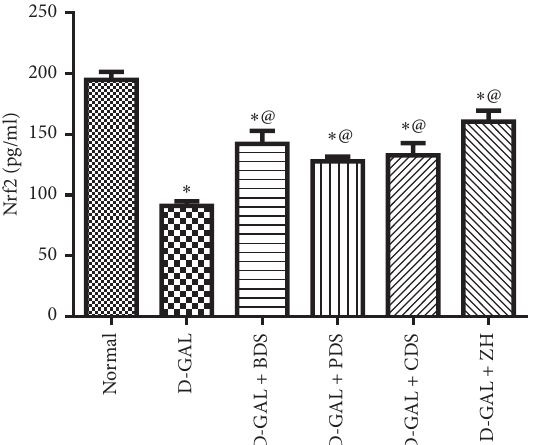
Figure 2: Effect of D. salina on hepatic Nrf2 levels in albino rats with age-related hepatic steatosis. Age-related hepatic steatosis was induced in rats by injections of D-galactose (300 mg/kg I.P) 5 days/week for 6 weeks. Rats injected with oral D-galactose for two weeks were treated with BDS (450mg/kg), PDS (30mg/kg), CDS (30mg/kg), or ZH (250 μ g/kg). Twenty-four hours later, the last dose of the treatment, rats were sacrificed and liver tissues were homogenized. Tissue homogenate were used for Nrf2 measurement. Data are expressed as mean ± SEM from the normal value. Statistical analysis was performed by one-way analysis of variance (ANOVA) followed by the Tukey–Kramer test for multiple comparisons. ∗ Significantly different from the normal control group at P ≥ 0 . 05. @ Significantly different from D-galactose control at P ≥ 0 . 05.